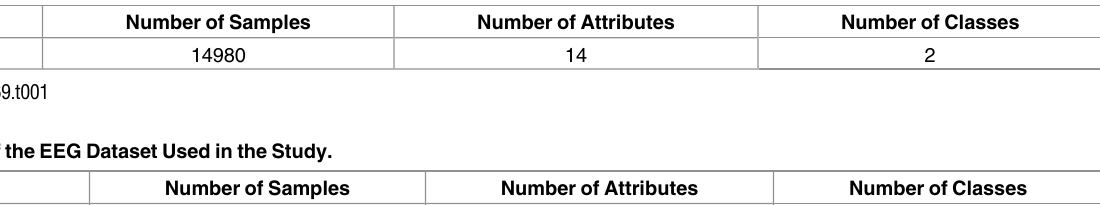
Table 1. Characteristics of the EEG Dataset Used in the Study.